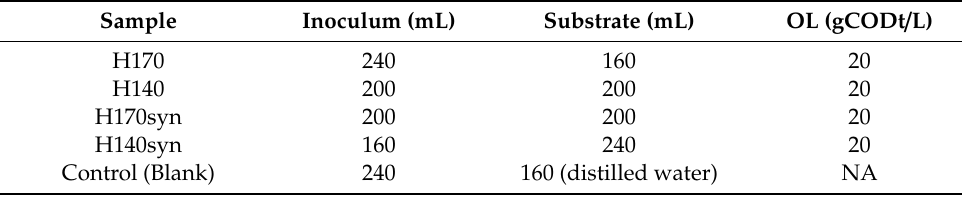
Table 3. Organic loading (OL) of AMPTS II-fed hydrolysates and synthetic hydrolysates. Sample Inoculum (mL) Substrate (mL) OL (gCODt / L) H170 240 160 20 H140 200 200 20 H170syn 200 200 20 H140syn 160 240 20 Control (Blank) 240 160 (distilled water) NA NA: Not